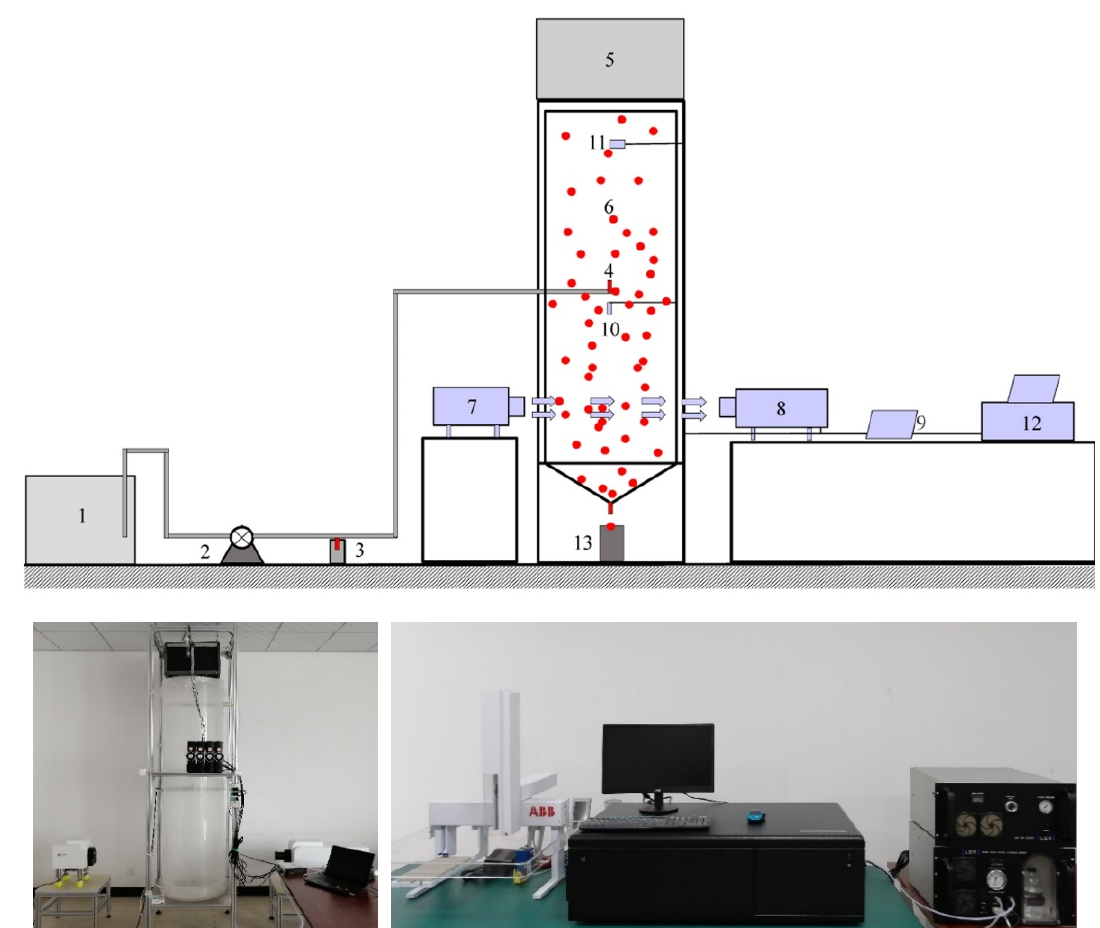
Figure 1. Schematic and site photograph of the experimental device (1—water tank; 2—water pump; 3—the micro-droplets sample collection bottle; 4—nozzle; 5—acoustic generator; 6—air chamber; 7—laser-emitting end; 8—laser-receiving end; 9—data analysis computer; 10—temperature and humidity sensors; 11—environmental water vapor sampling